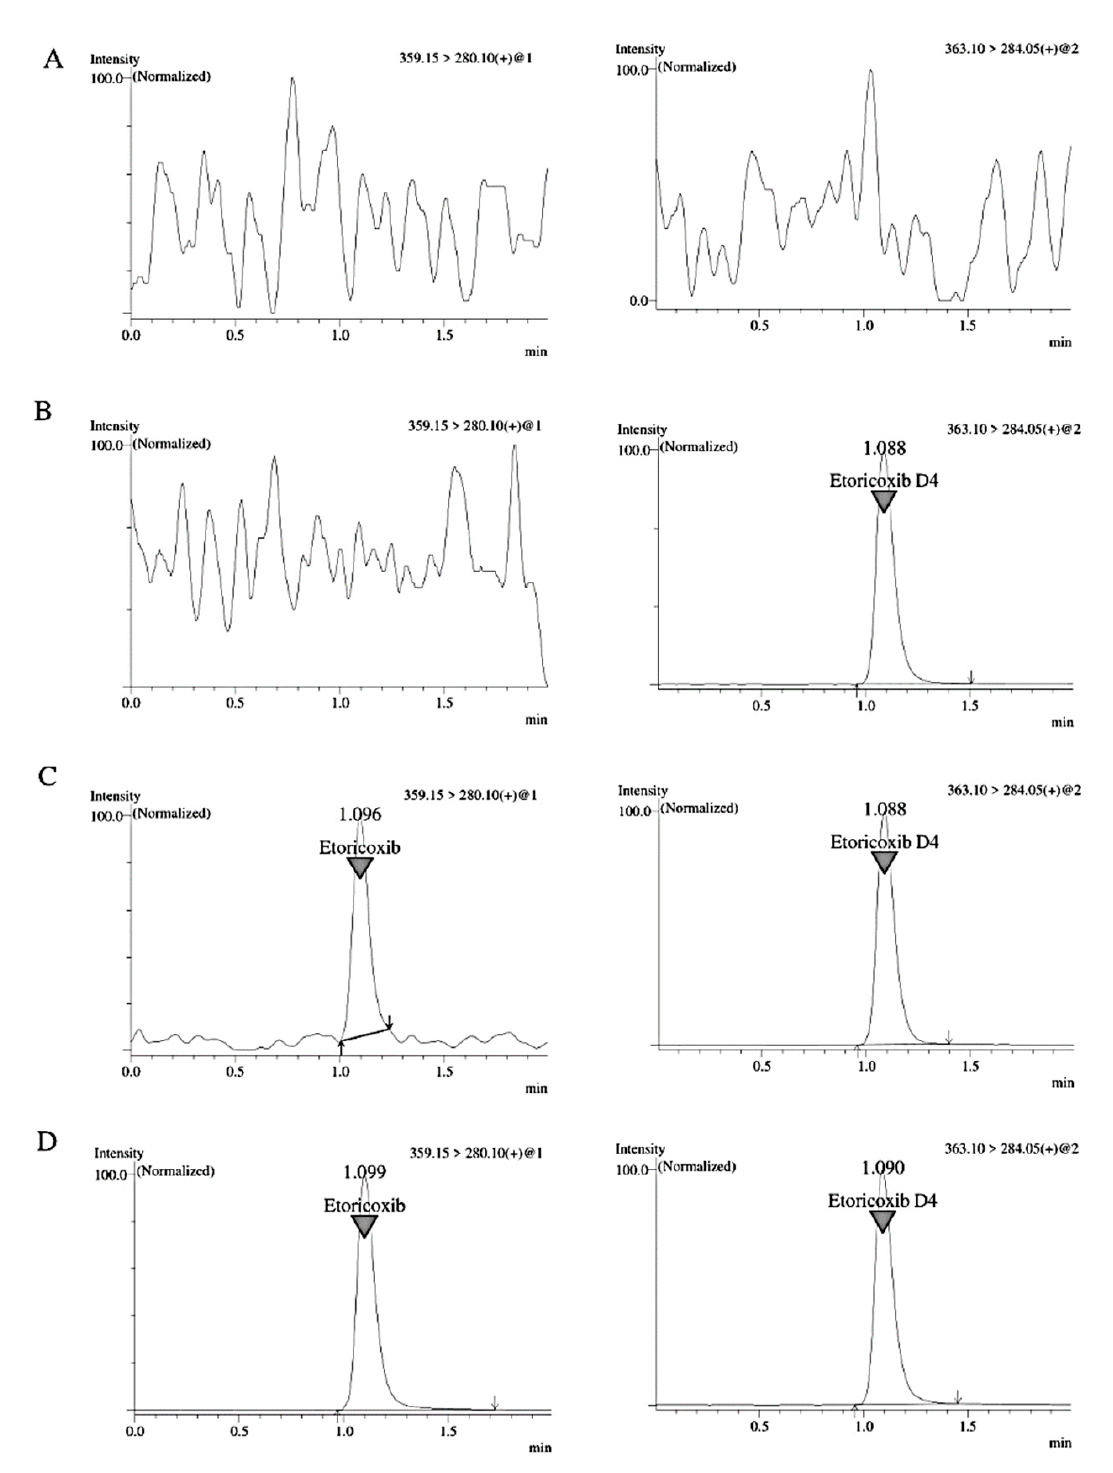
Figure 2. Mass chromatograms of ( A ) blank sample, ( B ) zero sample, ( C ) LLOQ of etoricoxib (10.00 ng/mL) and ( D ) a subject’s sample at 2400.45 ng/mL